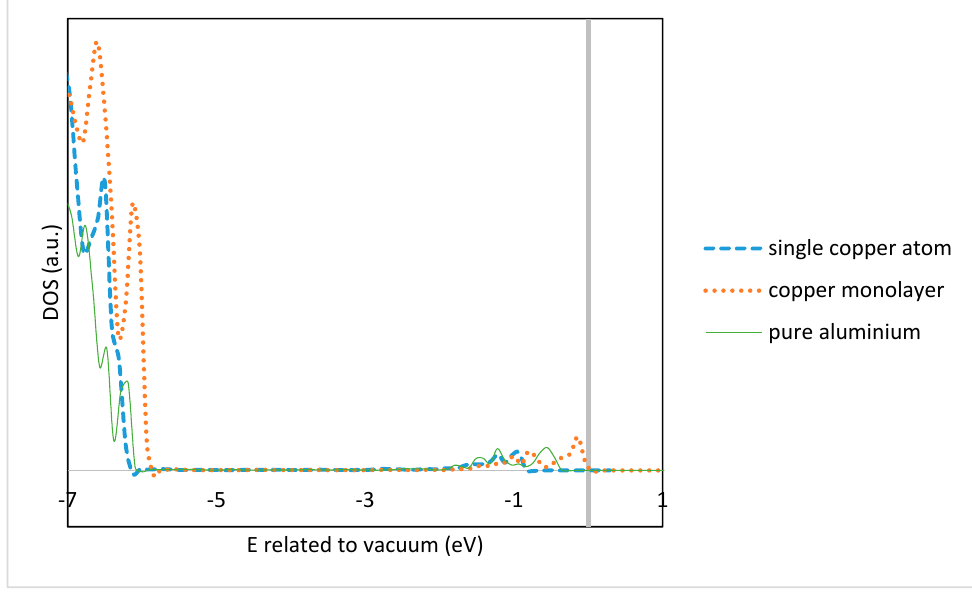
Figure 6. Comparison of the valence band edges of the inner layer of the supported oxide on pure Al, Al with a single copper atom and Al with a copper monolayer in l = 1 (a.u.: Arbitrary units). The reference energy is set to the vacuum level.